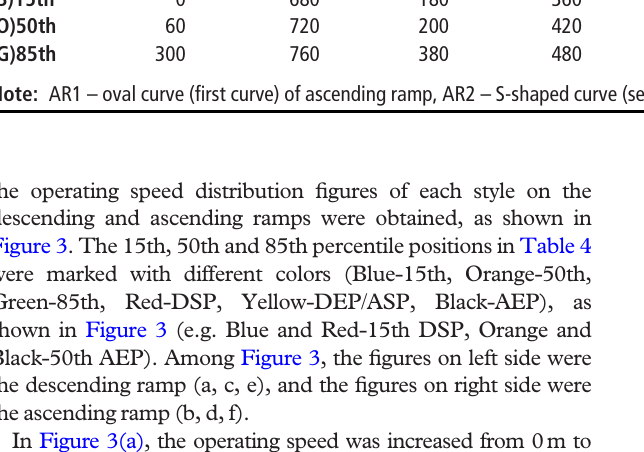
Green-85th, Red-DSP, Yellow-DEP/ASP, Black-AEP), as